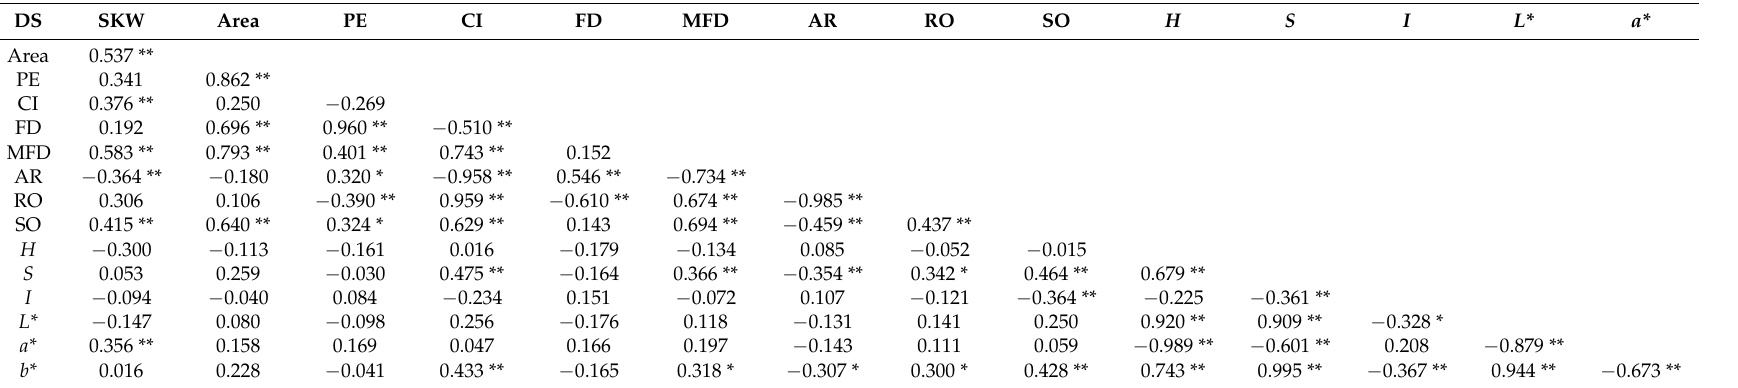
Table 5. Pearson’s correlation coefficient matrix for all investigated image shape and color descriptors for all studied wheat